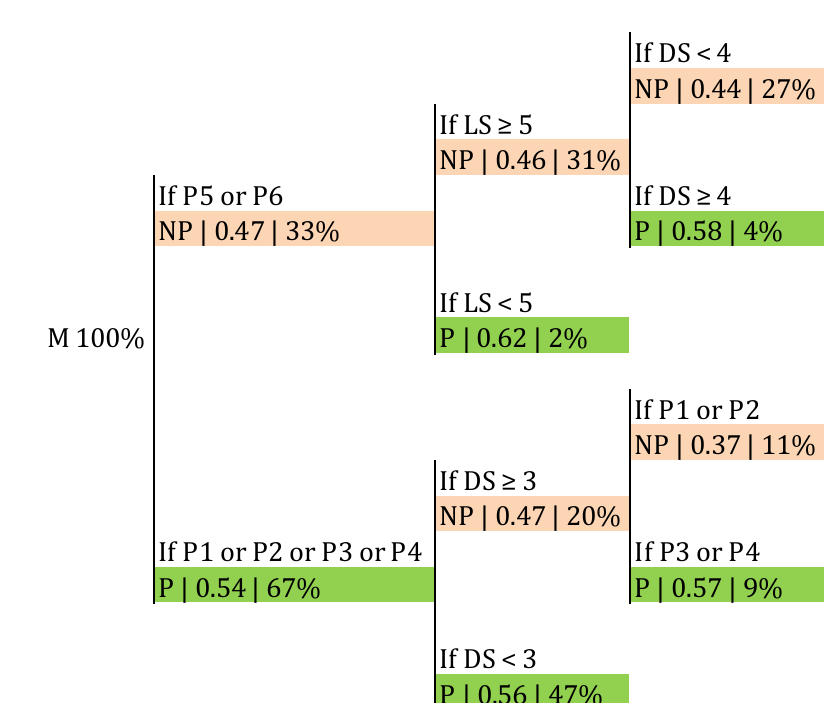
Figure 10. Probability of a point in the side-out depending on the Rotation, the LS and DS. P: rotation.